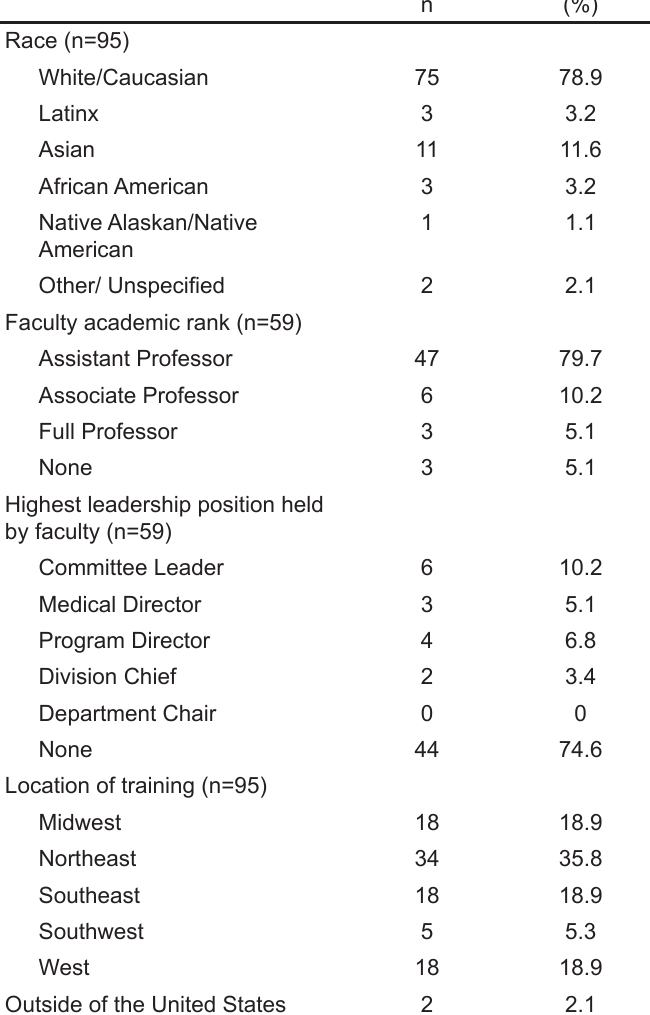
faculty and residents in emergency